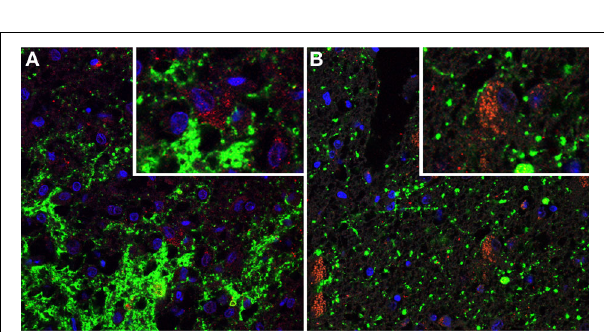
FIGURE 4 | Immunofluorescent photomicrographs showing serotonin transporter (SERT)-immunostaining (shown in green) combined with immunostaining for Agouti Related Peptide (AGRP) (shown in red). Cell nuclei are shown in blue. (A) The IFN of subject 00007. Note heavily stained SERT-positive fibers. The high power insert shows basket-like SERT staining surrounding neurons which are not immunoreactive for AGRP (B) The IFN of subject 01005. The high power insert shows an AGRP immunoreactive cell surrounded by SERT-positive fiber, suggesting nerve